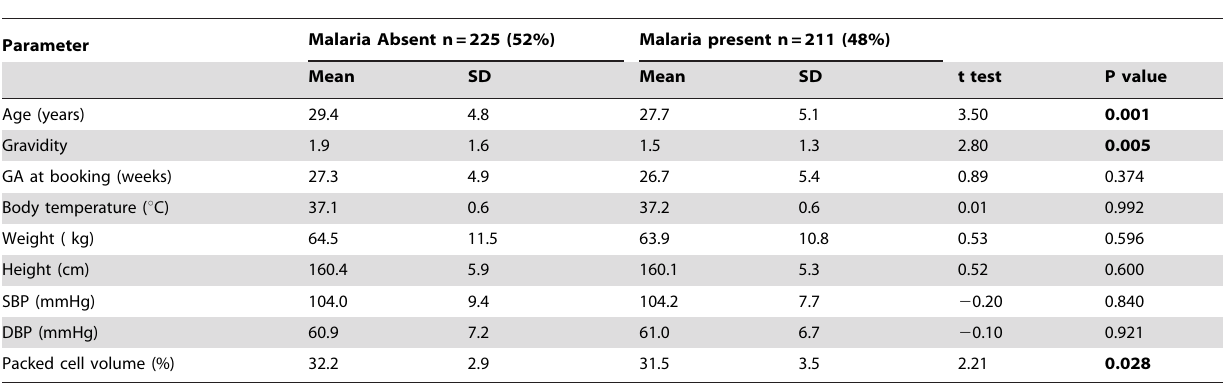
Table 1. Clinical Characteristics of Mothers at recruitment by Malarial Status.